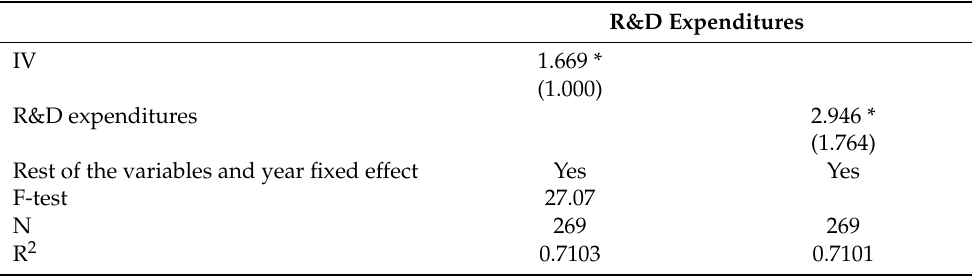
Table 3. First and second stages of IV